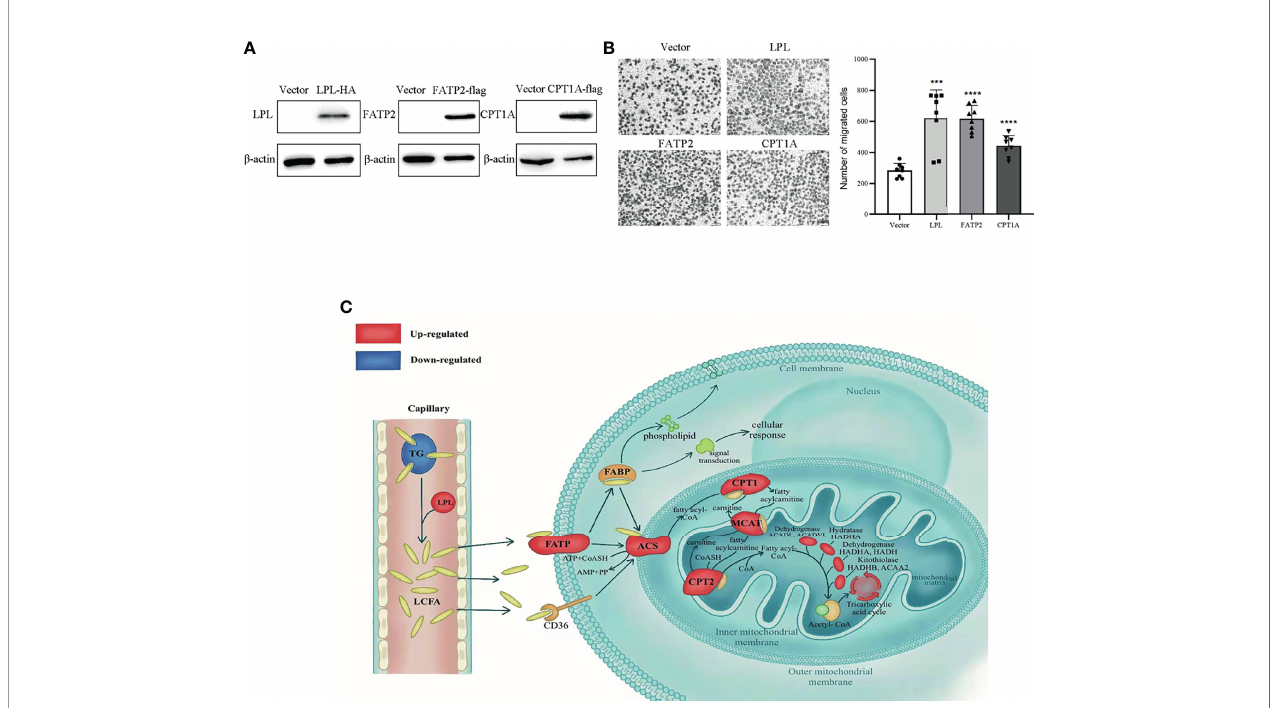
FIGURE 7 | Activated lipid metabolism in thyroid carcinoma. (A) Overexpression of LPL, FATP2 and CPT1A in BHP10-3 cells were con fi rmed by western blot. (B) Cell migration was examined in BHP10-3 cells with LPL, FATP2 and CPT1A overexpression. *** p < 0.001, **** p < 0.0001. All error bars indicate s.d. , two-tailed unpaired t -test. (C) As shown, long-chain fatty acids (LCFAs) are released from triglycerides (TGs) by lipoprotein lipid (LPL) and transported to cells by fatty acid transport protein 2 (FATP2). Carnitine palmitoyltransferase 1A (CPT1A) controls the utilisation of LCFA for energy supply. Furthermore, LCFAs can be used for cell construction and signal transduction. Red indicates up-regulation and blue indicates down-regulation. TG, triglyceride; FABP, fatty acid binding protein; ACS, Acyl- coenzyme A synthetase; CPT2, Carnitine palmitoyltransferase 2; MCAT, mitochondria carnitine acylcarnitine